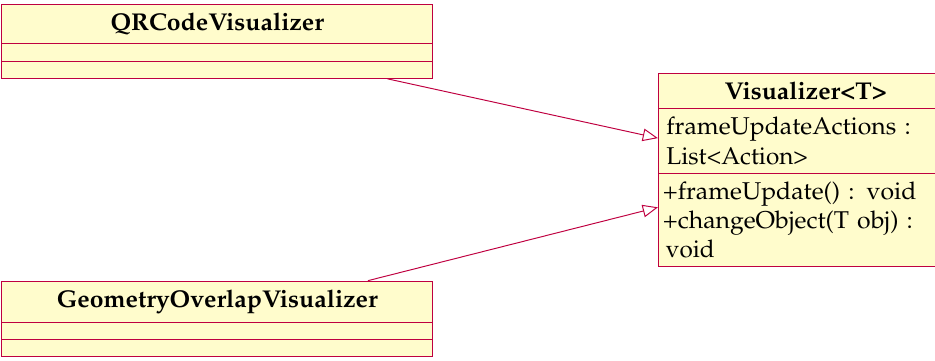
Figure 18. Class diagram of the GeometryOverlapVisualizer with all essential functions and fields, and its connection to its parent class.